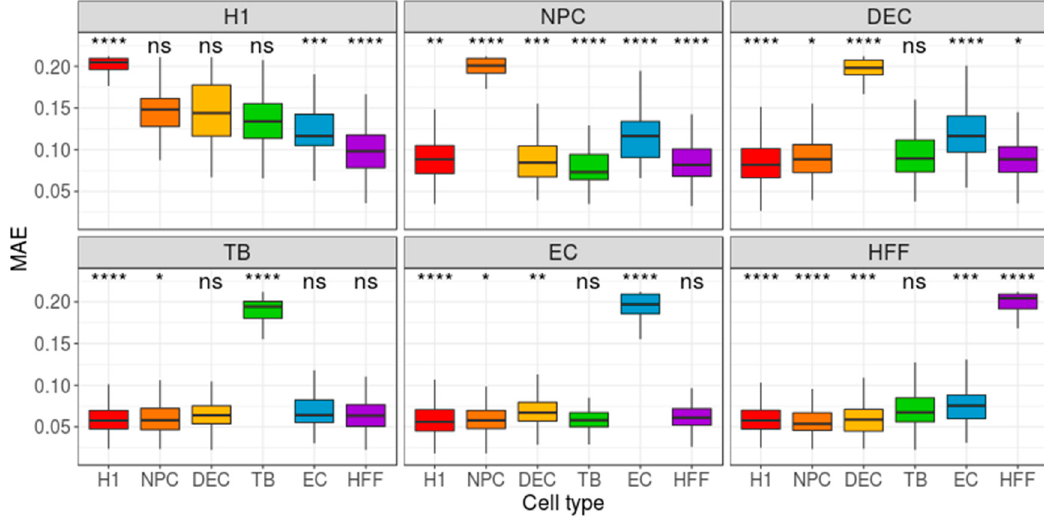
Figure 3. Distribution of group-based, cell-centered MAE scores, calculated across 200 genes that have the highest gene-centered MAE scores. The 200 genes with the highest MAE scores were detected separately for each cell type, and then the cell-centered MAE score was calculated based on these genes. Panel titles indicate the focus groups (for example, the panel entitled ‘H1’ shows the cell-centered MAE score distribution, calculated for each cell type, based on 200 genes that have the highest gene-centered MAE scores within the H1 group). H1: human embryonic stem cells ( n = 375 cells); NPC: neural progenitor cells ( n = 173 cells); DEP: definitive endoderm progenitors ( n = 138 cells); EC: endothelial cells ( n = 105 cells); TB: trophoblasts ( n = 69 cells); HFF: human foreskin fibroblasts ( n = 159 cells). Each group was compared to all other cell types, combined, using a Wilcoxon test. ns: non-significant ( p > 0.05), * p ≤ 0.05, ** p ≤ 0.01, *** p ≤ 0.001, **** p ≤ 0.0001.